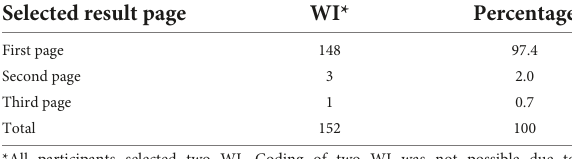
TABLE 4 Search engine’s result page.